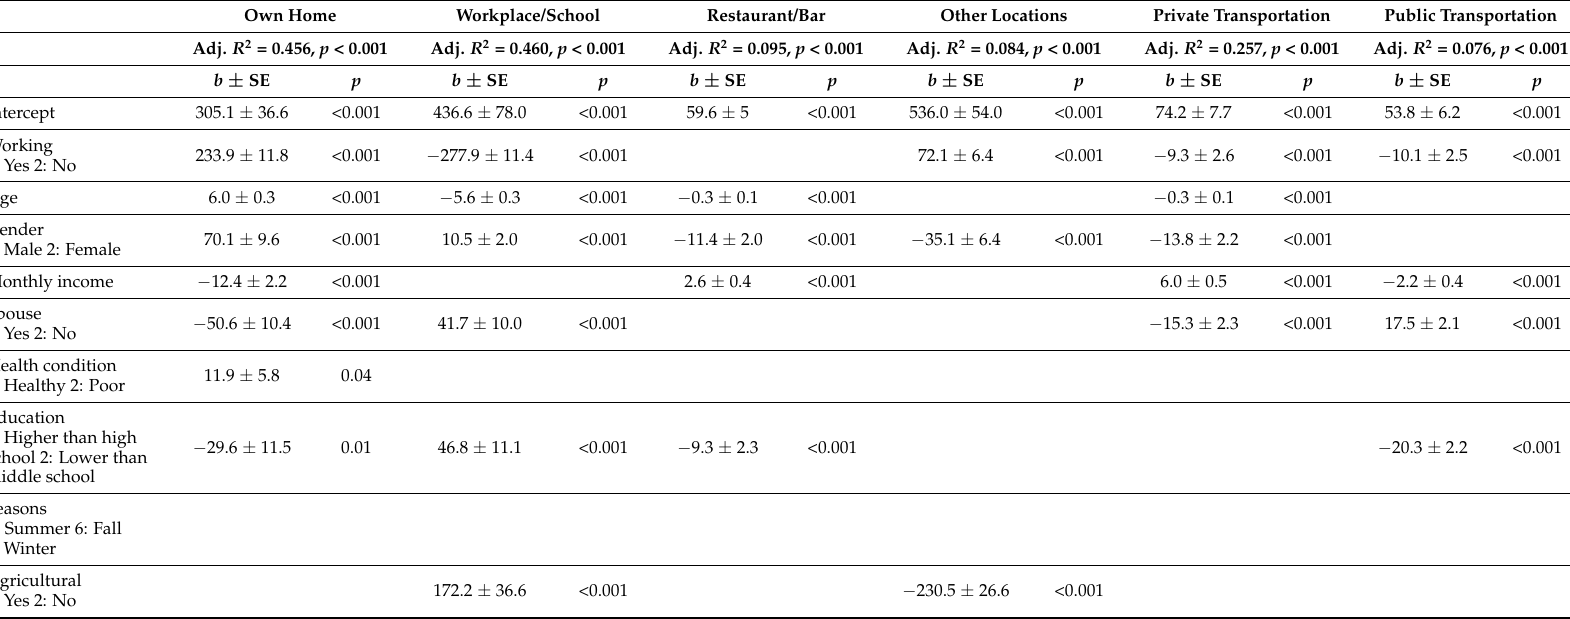
Table 5. The factors that influence the time spent at six locations in